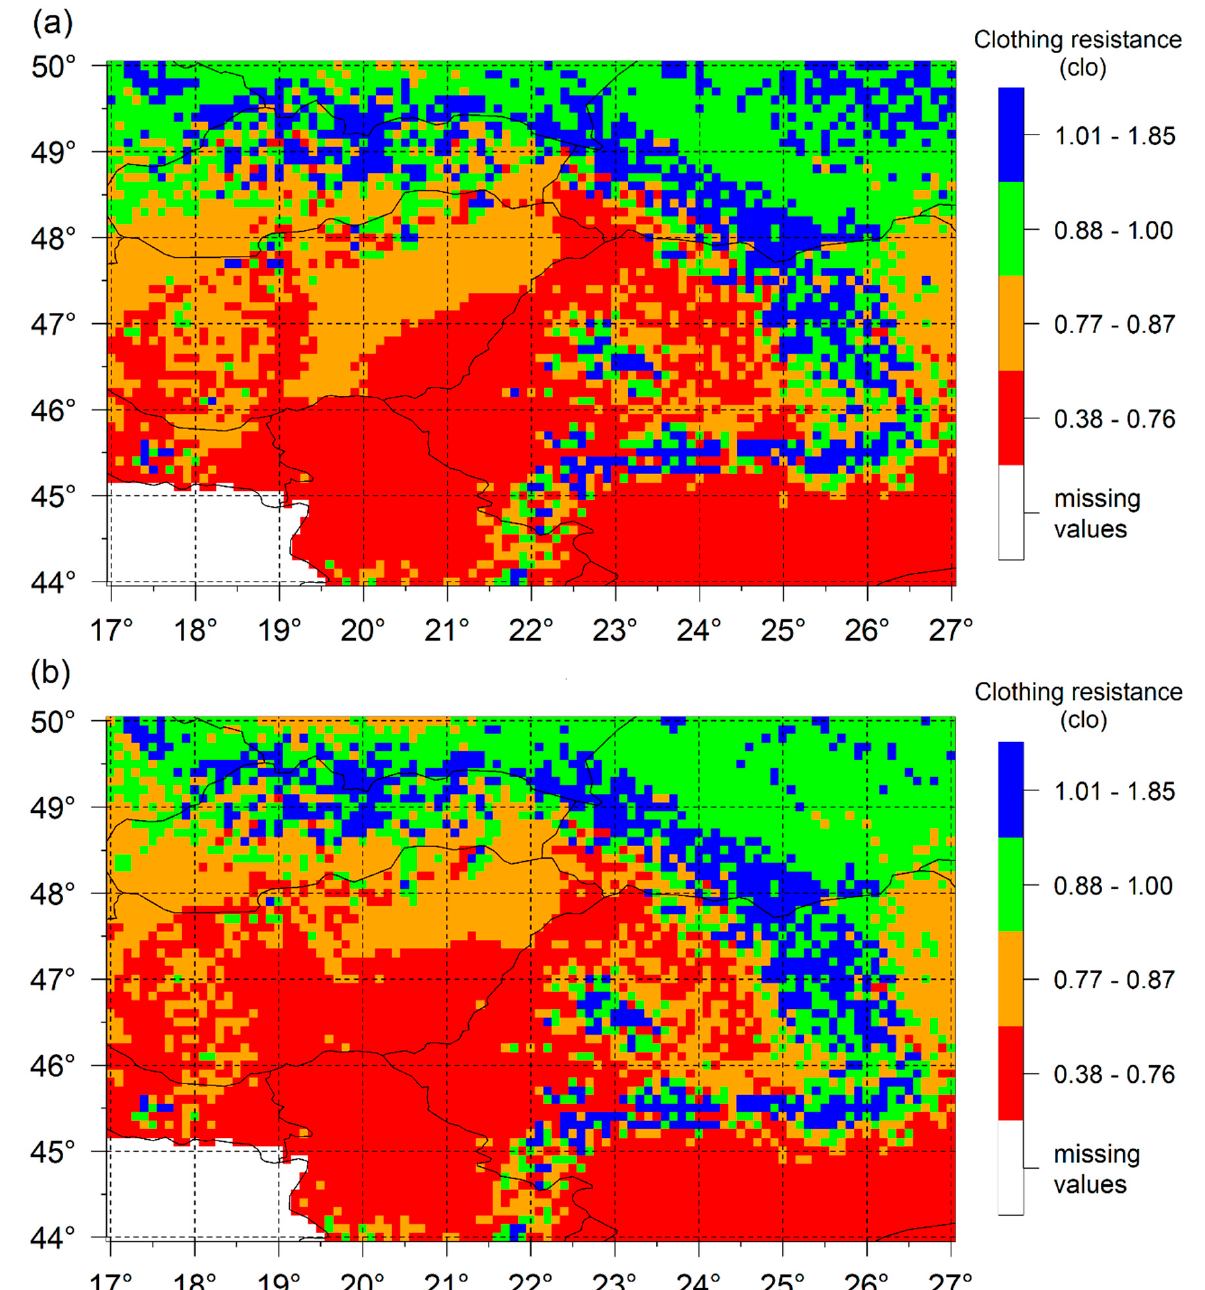
Figure 6. Spatial distribution of clothing thermal resistance values for year obtained by calculating operative temperature by using deterministic ( a ) and by statistical deterministic ( b ) procedures for person 1 representing the average adult Hungarian male in the CarpatClim dataset region for the period 1971–2000.